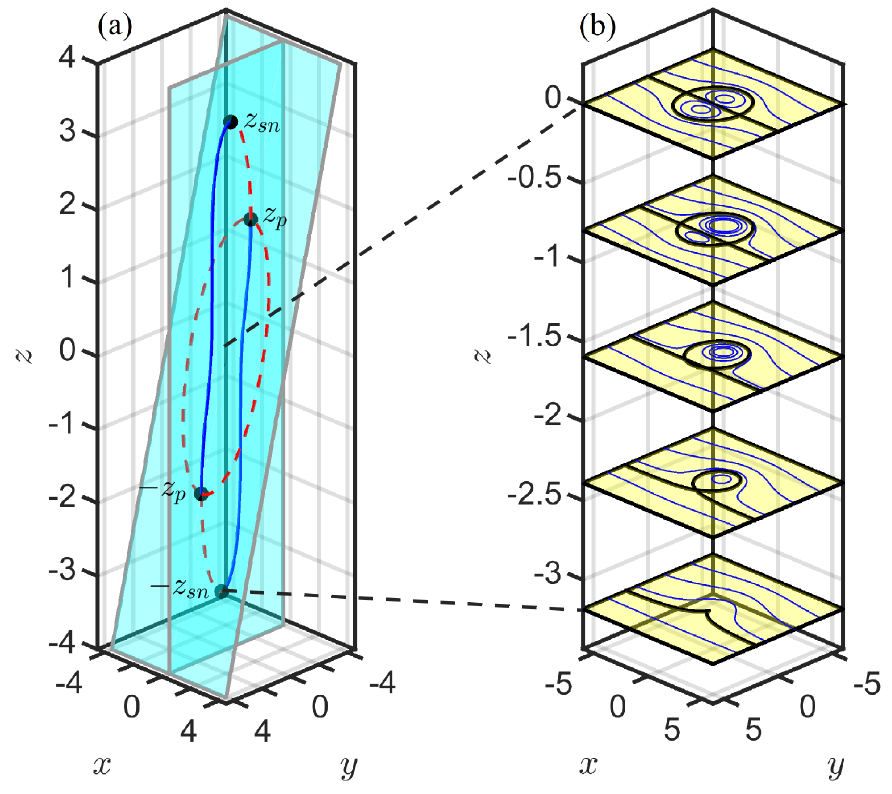
Figure 5. Bifurcation diagram ( a ) and contour slices ( b ) for the Z = 1 case. Panel ( a ) illustrates the generation/destruction of stable (solid blue curves) and unstable (dashed red curves) fixed points. At z = − z sn ≈ − 3.18, a saddle-node bifurcation leads to the creation of a saddle and a center, both −√ on the plane x = 0. At z = − z p = 3, a pitchfork bifurcation causes the saddle to give way to a center on x = 0 and two saddles on y = − z . Similar bifurcations occur for z > 0, destroying the fixed points. The contour slices of panel ( b ) illustrate the three-dimensional volume trapped by the heton at five equally spaced planes between z = − 3.18 and z =